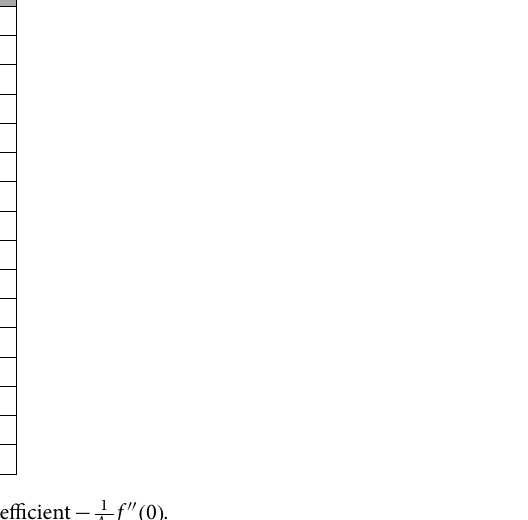
Table 3. Numerical values of skin friction coefficient −